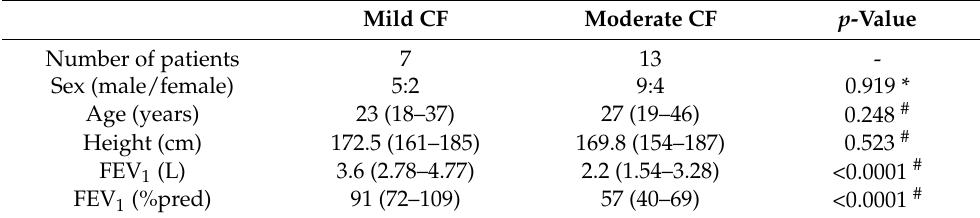
Table 1. Patient